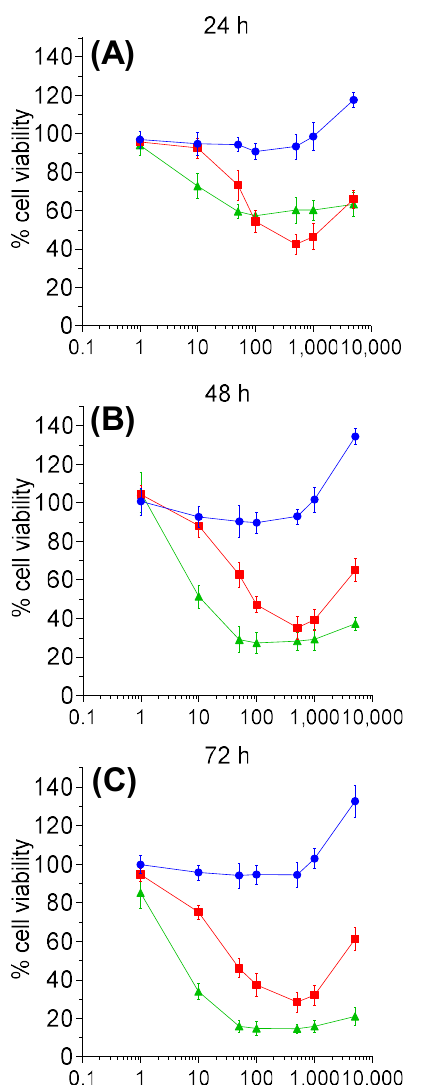
Figure 1. Cell viability responses to paclitaxel treatment in primary melanocytes and malignant melanoma-derived cell lines. The MTT assay illustrates dose–response curves of the primary melanocytes, RPMI-7951 and A375 cells to different concentrations of paclitaxel, ranging from 1 nm to 5 µ M. The effect of paclitaxel on cellular growth was assessed at 24 ( A ), 48 ( B ), and 72 h ( C